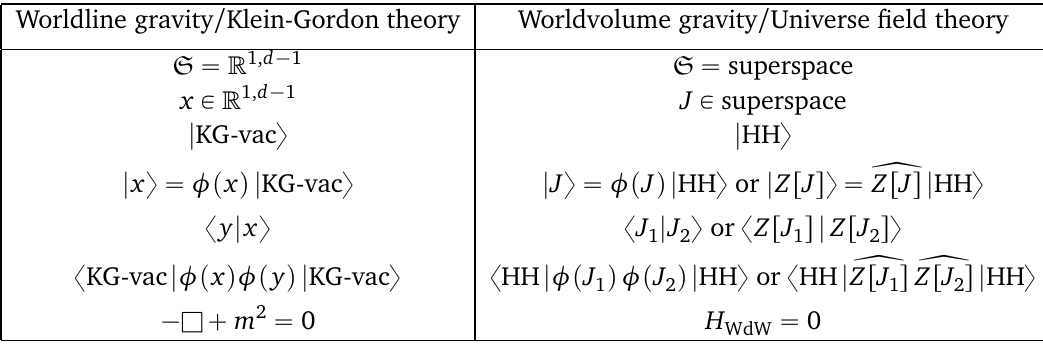
Table 1: Comparison between objects in worldline gravity, whose third quantization leads to Klein-Gordon theory, and higher-dimensional gravity theories whose third- quantized description should perhaps be called universe field theory, imitating the name string field theory. The word superspace is used like it is used in quantum cosmology, it is the space of spatial metrics modulo spatial diffeomorphisms. In gen- eral, S is the space of boundary conditions in the “worldvolume path integral", and each element of S represents a boundary condition that can be imposed on a single connected component of the boundary. The notation involving Z r J s ’s is due to [ 17 ]